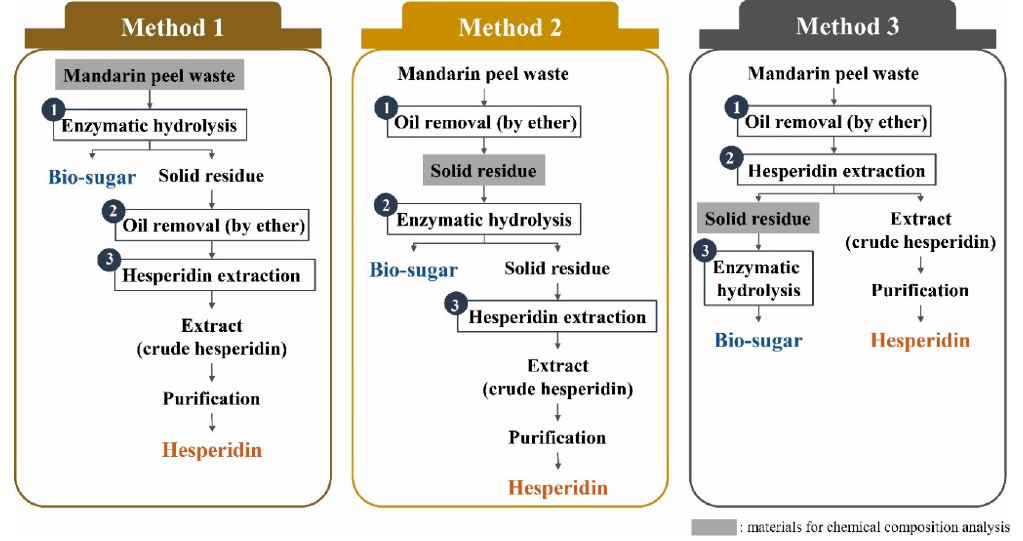
Figure 2. Schematic of the three methods used to produce biosugars and hesperidin from mandarin peel waste